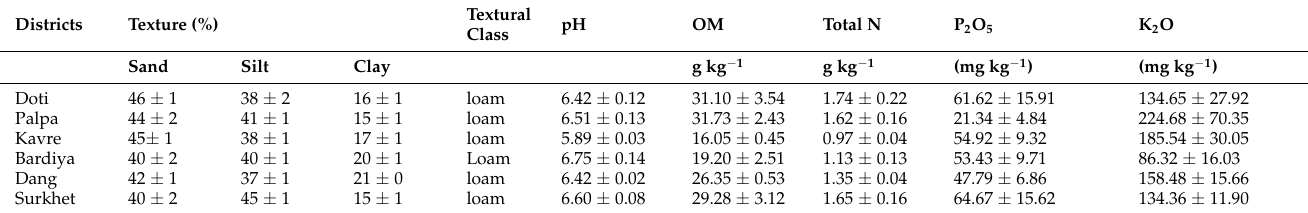
Table 1. Soil properties—texture, pH, organic matter (OM), total nitrogen (N), available phosphorous (P 2 O 5 ) and available potassium (K 2 O) across districts (mean ± standard error